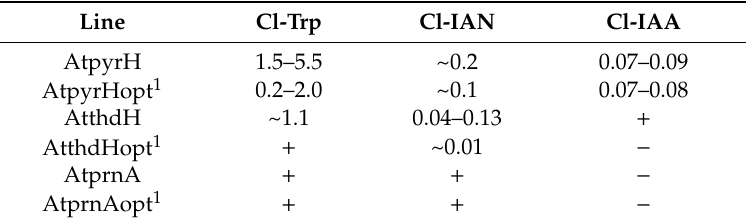
Table 2. Analysis of chlorinated compounds in di ff erent transgenic Arabidopsis thaliana lines. The values ( µ g / g dry weight) are approximates, as reproducible results were not obtained in all samples, and given as a range of lowest to highest detected value over all lines where the compound was detected. In samples indicated with ( + ) a peak was identified but that was below the limit for quantification. ( − ) indicates below detection limit.